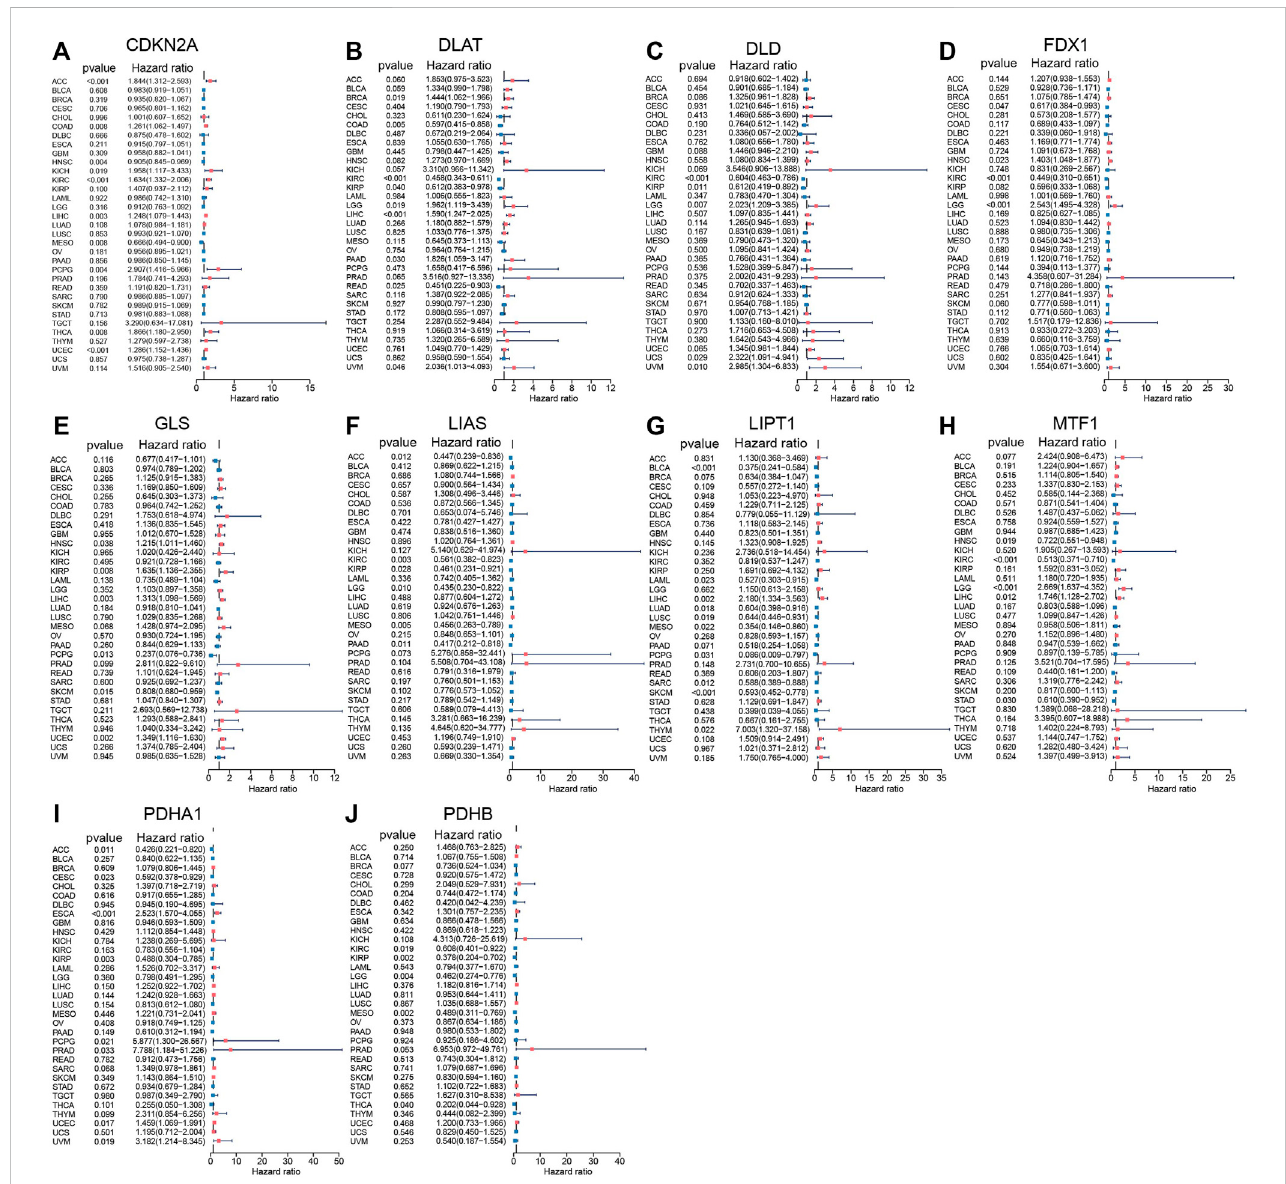
FIGURE 2 Prognosticvalues of10 CRGs inpan-cancerexploredby Univariate Cox analysis. (A) CDKN2A . (B) DLAT . (C) DLD . (D) FDX1 . (E) GLS . (F) LIAS . (G) LIPT1 . (H) MTF1 . (I) PDHA1 . (J) PDHB .